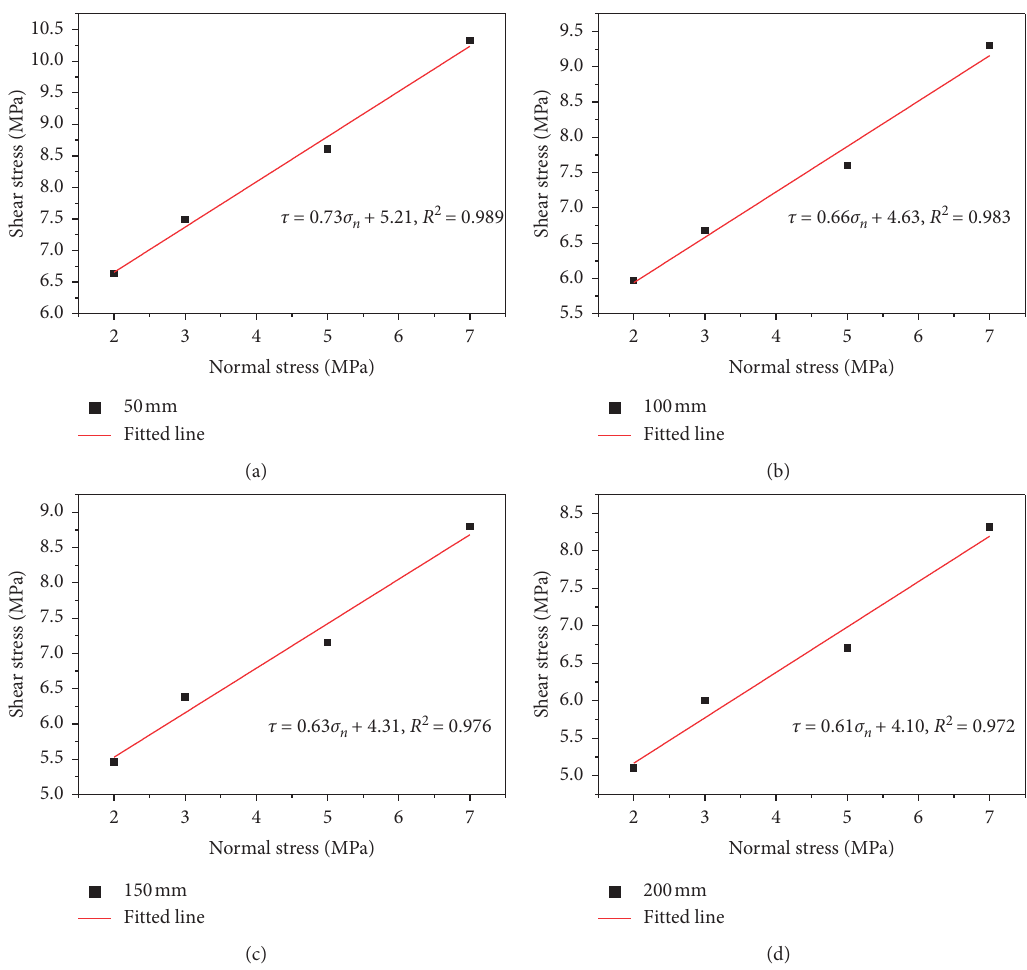
Figure 6: Shear tests results of coalcretes with different sizes. (a) 50mm, (b) 100mm, (c) 150mm, and (d) 200mm. Table 5: The experimental and calculated mechanical parameters of coalcrete.